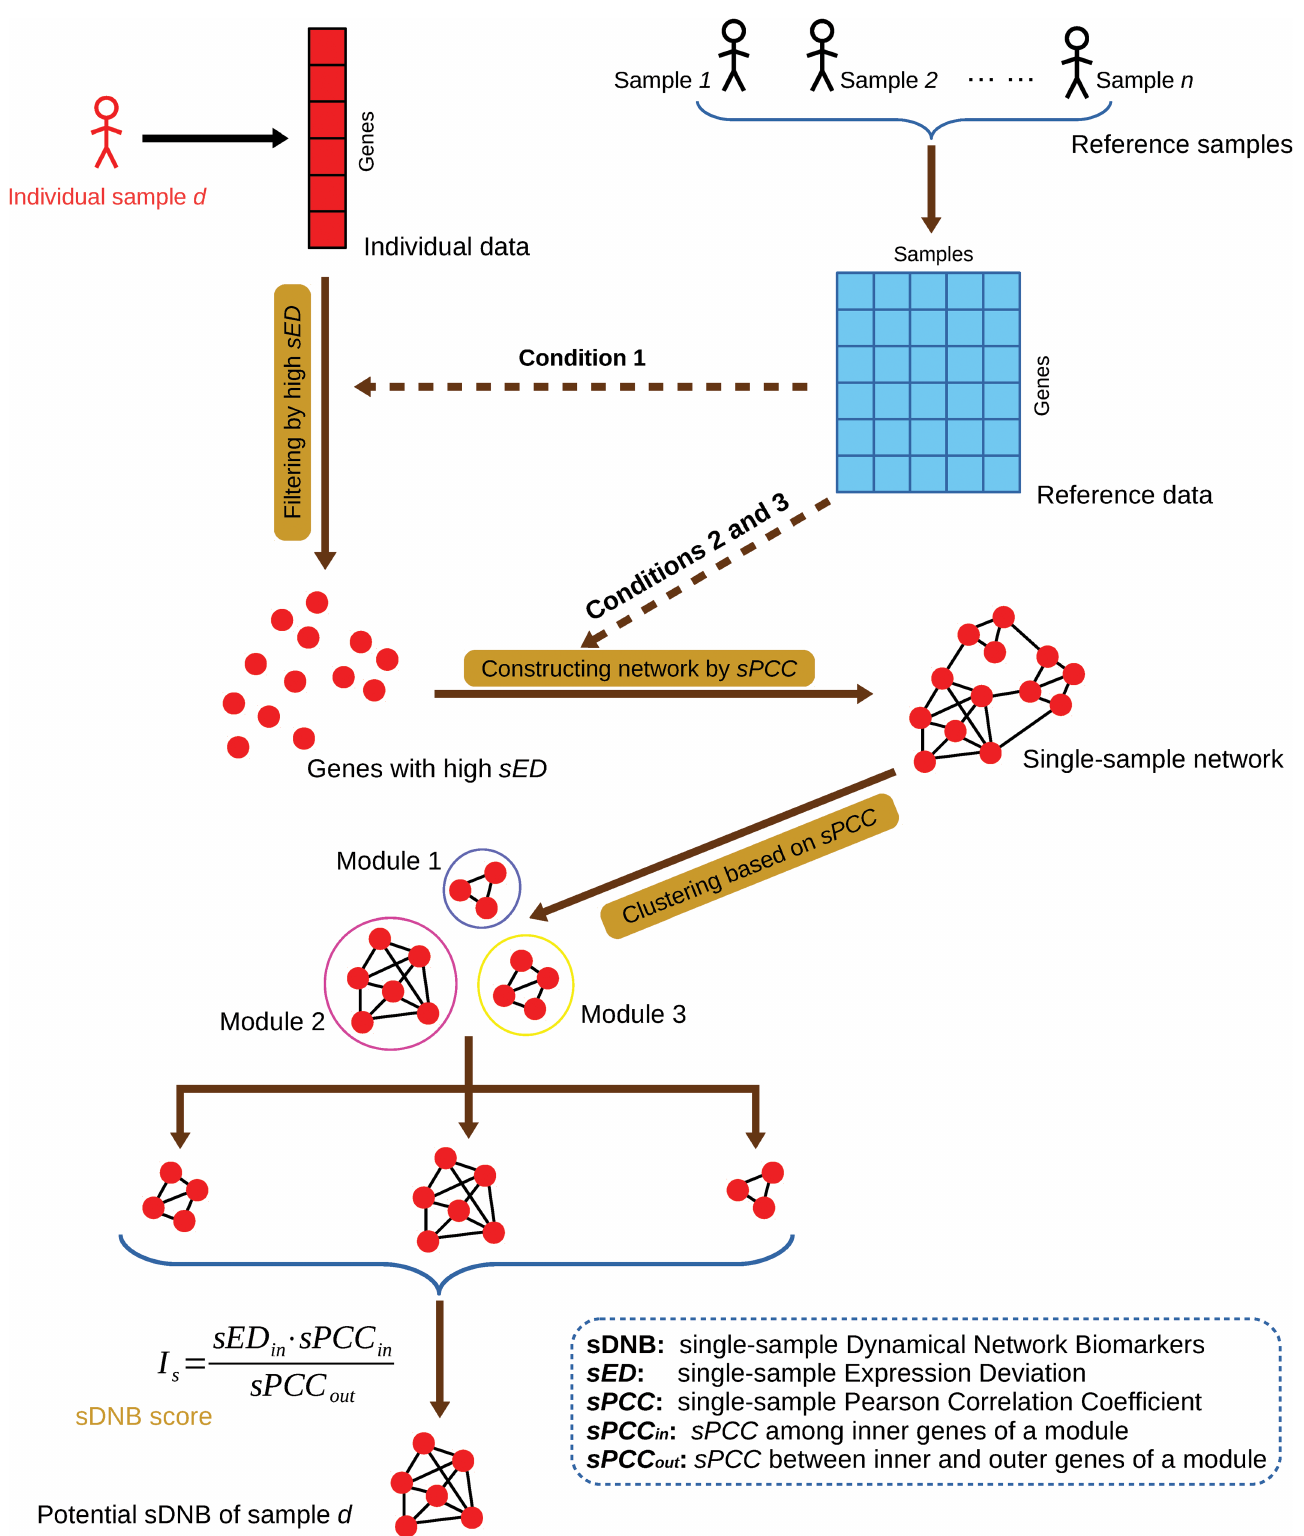
Fig 2. Flowchart of the algorithm for identifying potential sDNB in a single sample. sED and sPCC can be calculatedby the method shown in Fig 1B. The hierarchicalclusteringalgorithmwas employedin the clustering process, and the value of 2 minus the absolutevalue of sPCC was used as the distancebetweengenes for the hierarchical clusteringalgorithm.